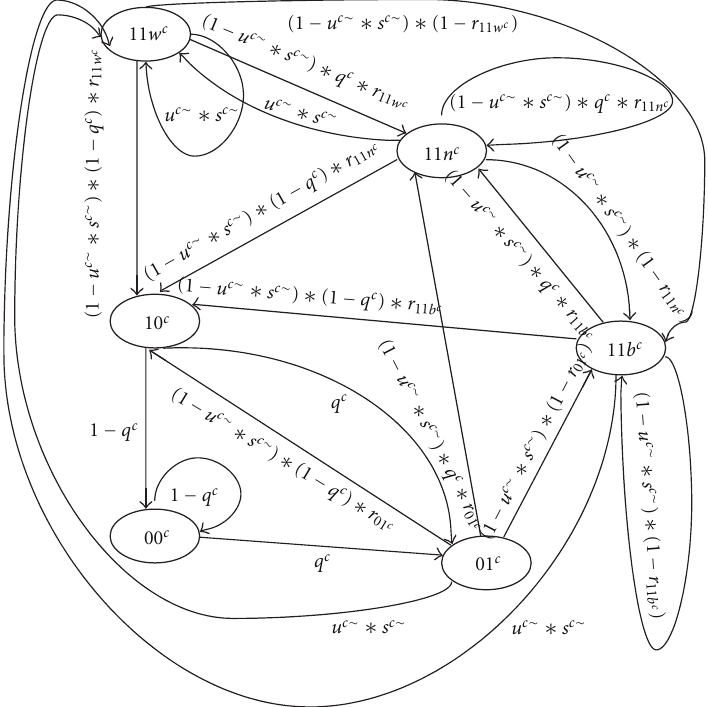
Figure 3: A state transition diagram of a c -class priority bu ff er of SE( k